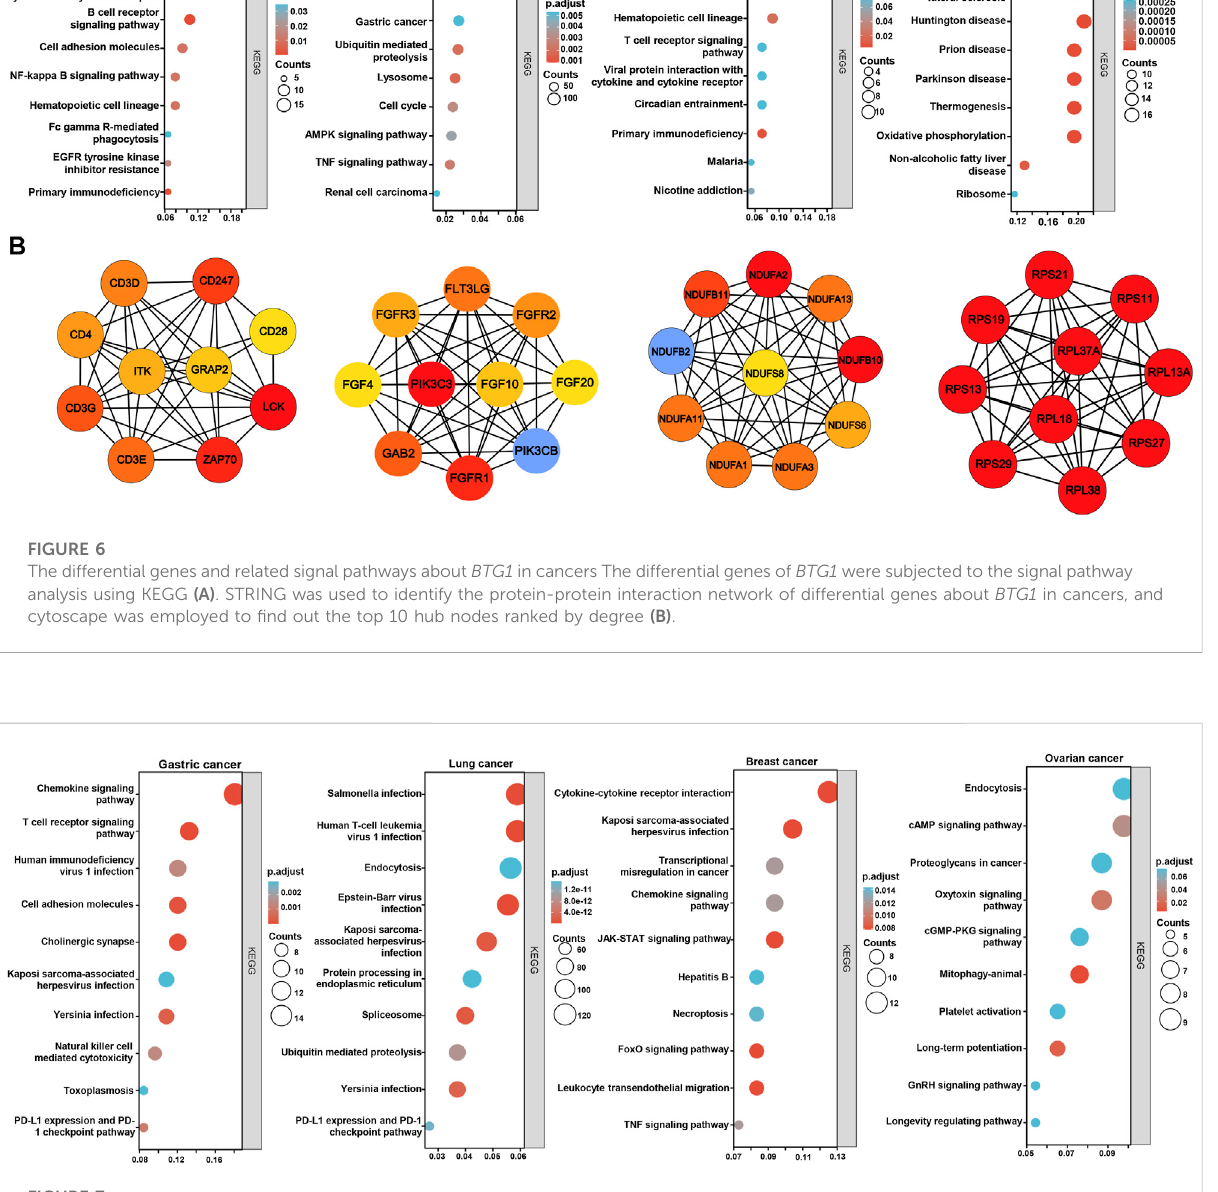
FIGURE 7 The BTG1 -relatedsignalpathwaysincancers.Thetop BTG1 -relatedgeneswerescreenedandclassi fi edintothesignalpathwaysofKEGGusing xiantao